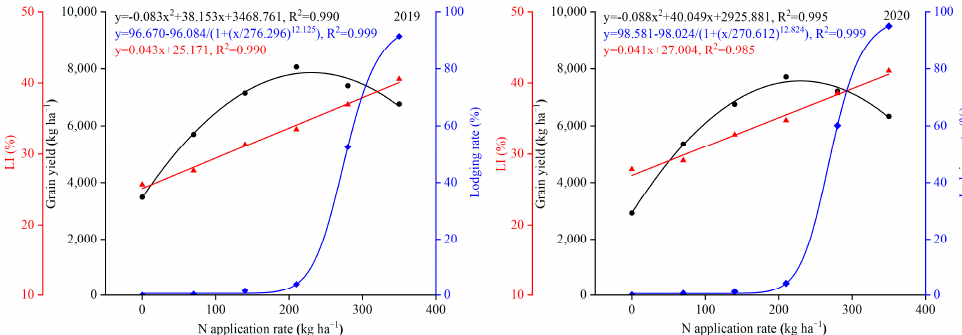
Figure 5. Relationships between grain yield, lodging percent and LI and N application rate in 2019 and 2020. LI: lodging index.